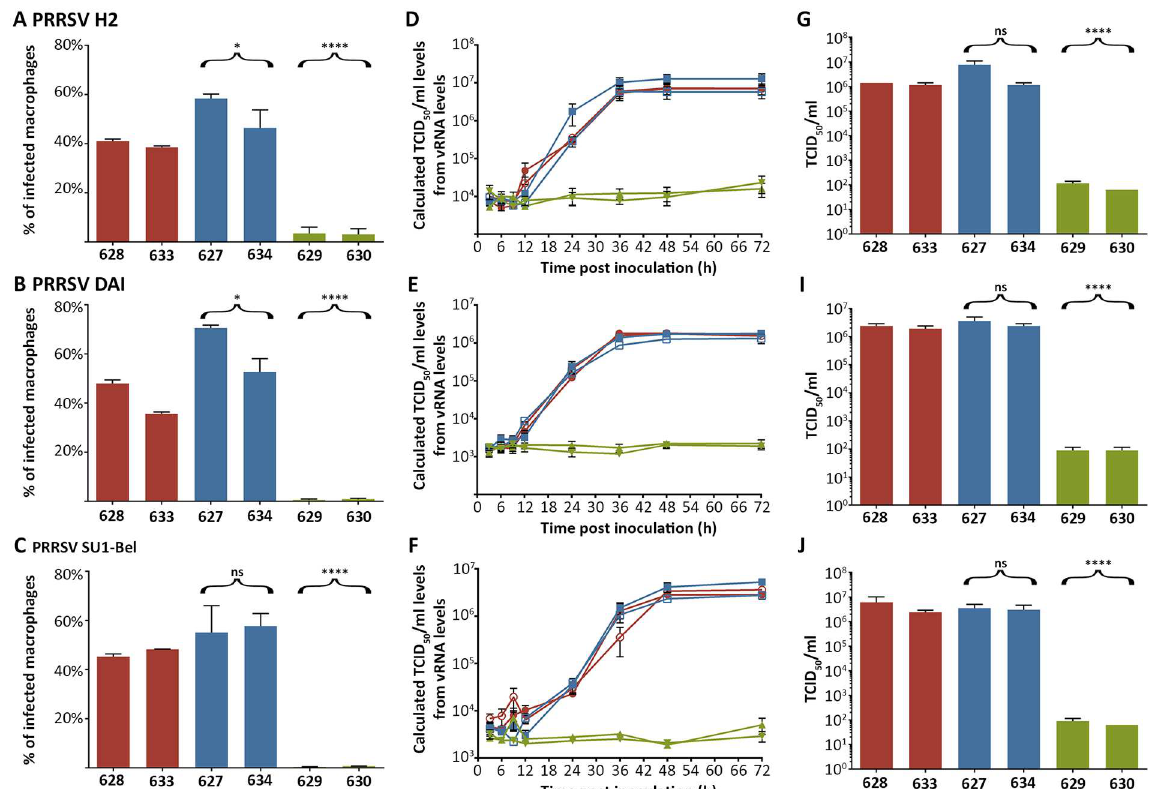
Fig 5. Δ SRCR5 pulmonary alveolar macrophages (PAMs) are not susceptible to infection with PRRSV genotype 1. A-C) PAMs from wild type (red), heterozygous (blue), and Δ SRCR5(green)animals were inoculated at MOI = 1 of PRRSV genotype1, subtype 1 (strain H2, A), subtype 2 (strain DAI, B), and subtype 3 (strain SU1-Bel,C). 19 hpi cells were detached, fixed and stained with an anti PRRSV-Nprotein antibody and CD163. Infection was quantifiedby FACS analysis. Over 98% of infected macrophages were qualifiedas CD163positive. Infection levels were statistically analyzedusing an unpairedt-test of all wild type againstall heterozygous or all biallelic/ homozygousdata points. Error bars represent SEM, n = 3. D-F) Replicationgrowth curves of PRRSV genotype1, subtype 1 (strain H2, C), subtype 2 (strain DAI, D), and subtype 3 (strain SU1-Bel, F). PAMs from wild type (red, 628 filled circle, 633 open circle), heterozygous (blue, 627 filled square, 633 open square), and Δ SRCR5(green, 629 trianglepointingdown, 630 trianglepointing up) animalswere inoculatedat MOI = 0.1 of the respectivestrain. Cell supernatant was collectedat indicated time points to measure the releasedviral RNA by RT-qPCR. Error bars represent SEM, n = 3 * 2. G-J) Quantification of infectious particles producedat 48 hpi by TCID 50 analysis. Cell supernatant collectedat the 48 hpi time point of infection of the time-course experiment was analyzedfor infectiousviral particle production quantifiedby TCID 50 . Infection levels were statistically analyzedusing an unpairedt-test of all wt against all het or all Δ SRCR5. Error bars represent SEM, n =